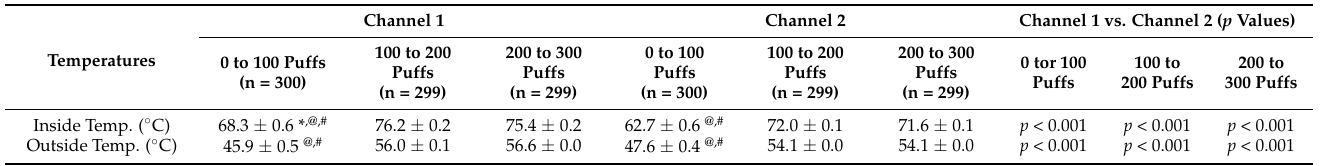
Table 1. Temperature